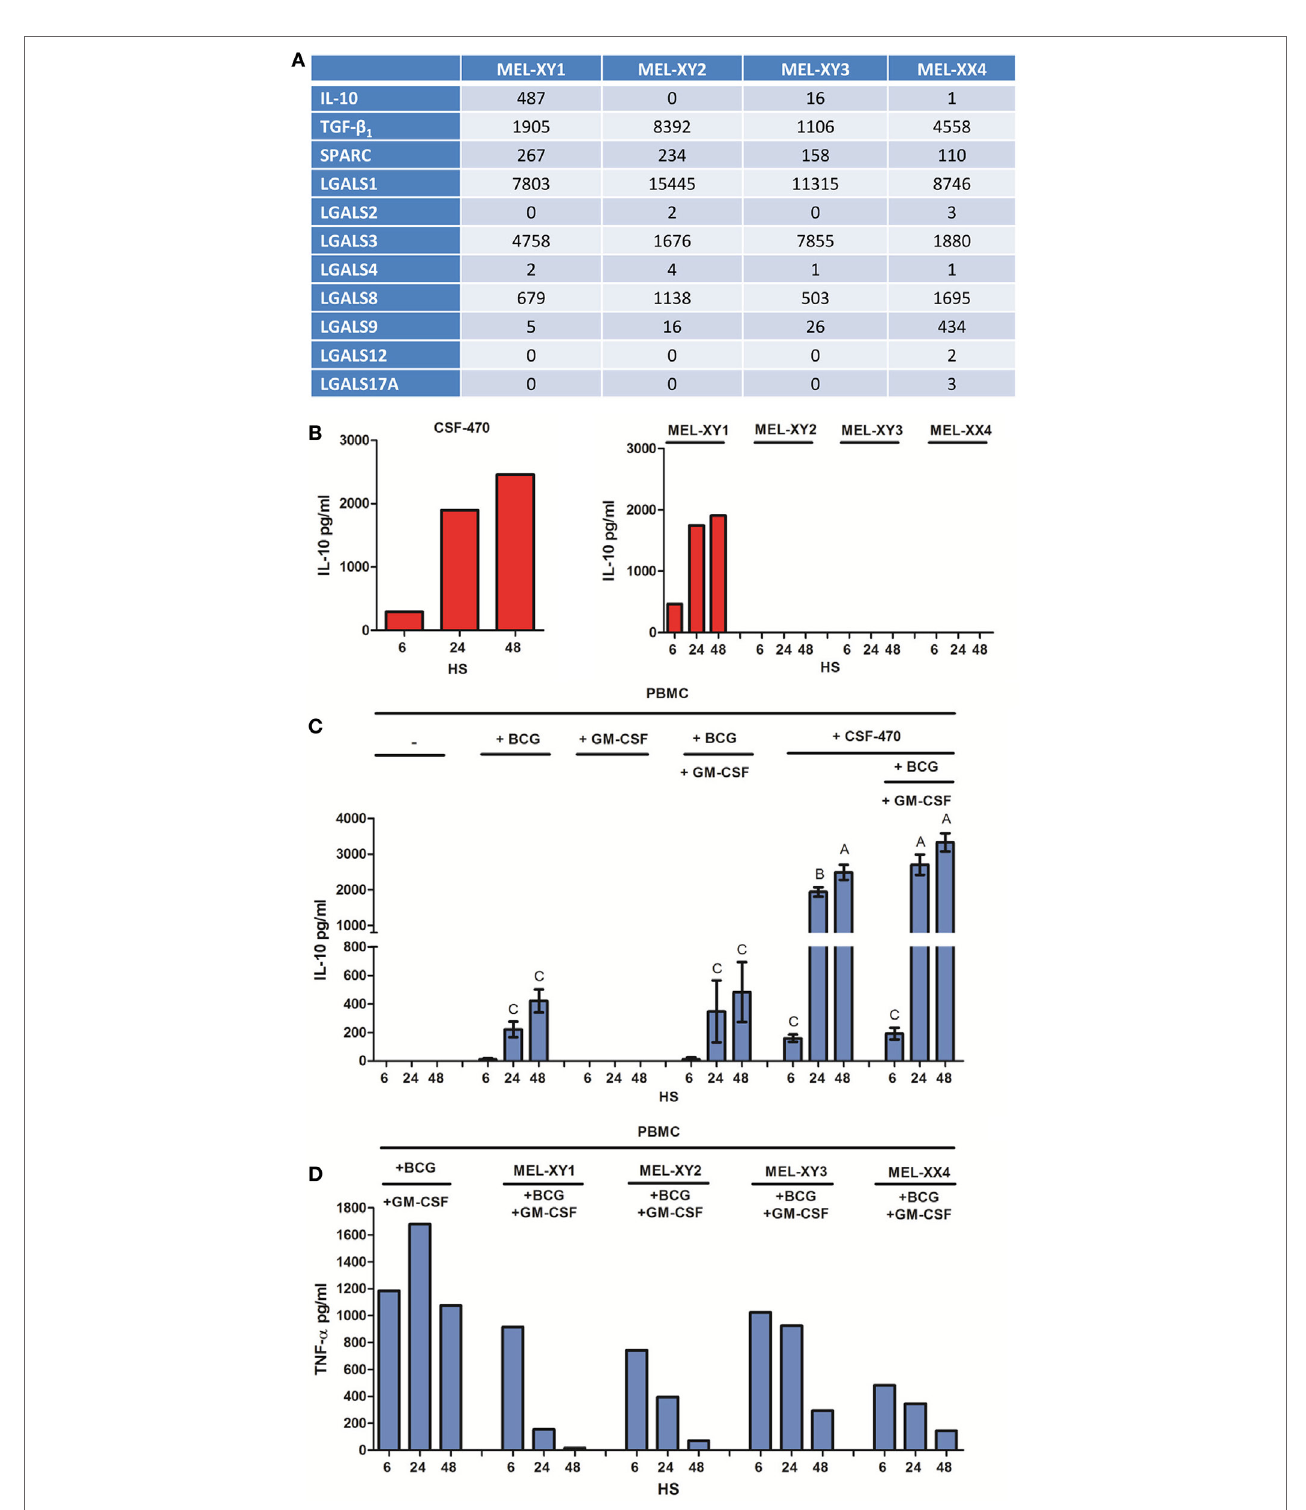
FigUre 5 | Anti-inflammatory cytokine production by CSF-470 vaccine. (a) IL-10, TGF- β , SPARC, and galectin expressions by RNAseq from MEL-XY1, MEL-XY2, MEL-XY3, and MEL-XX4 cell lines. (B) IL-10 detected in conditioned media of CSF-470 or each irradiated cell lines after 6, 24, and 48 h. (c) IL-10 detected in supernatants of peripheral blood mononuclear cell (PBMC) cocultures with CSF-470 with or without adjuvants. Bars with different letters are statistically different ( p < 0.05). (D) TNF- α release by PBMC exposed to each irradiated cell line plus adjuvants bacillus Calmette–Guerin and granulocyte macrophage colony-stimulating